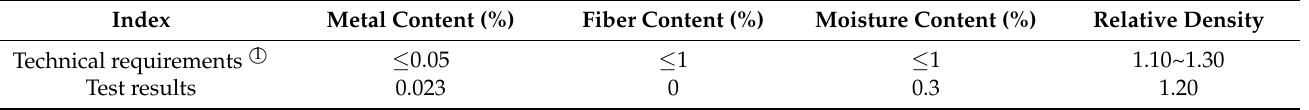
Figure 5. The infrared spectrum diagram of crumb rubber.